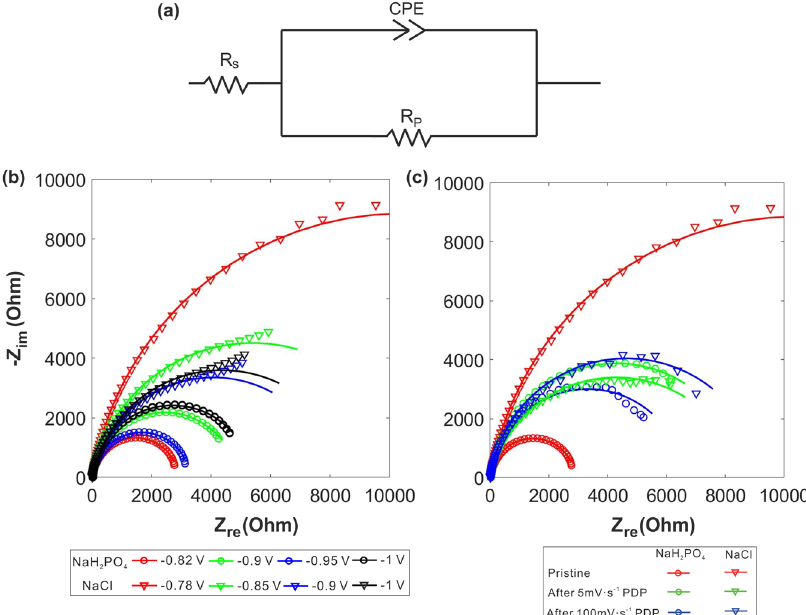
Fig. 2 EIS spectra of AA7075 in 0.62 M NaH 2 PO 4 and 3.5 wt% NaCl solution. The frequency range of all measurements is from 10 5 Hz to 1 Hz. a The equivalent circuit used to fi t the data. b Nyquist plot as a function of the applied potential. c Nyquist plot as a function of surface conditioning.